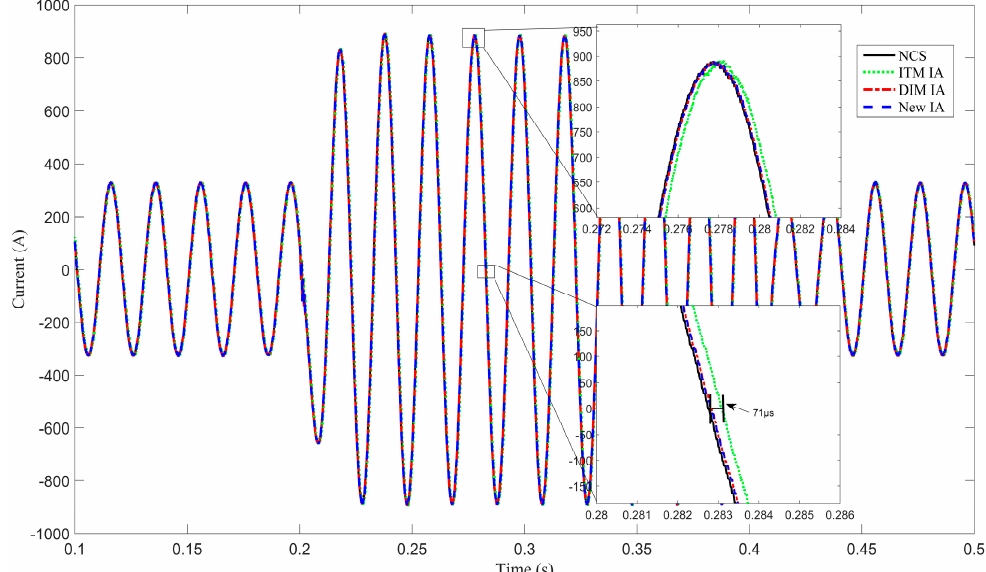
Figure 12. The current waveforms of power grid simulation branch in the DSS side of RITSS with the new IA.